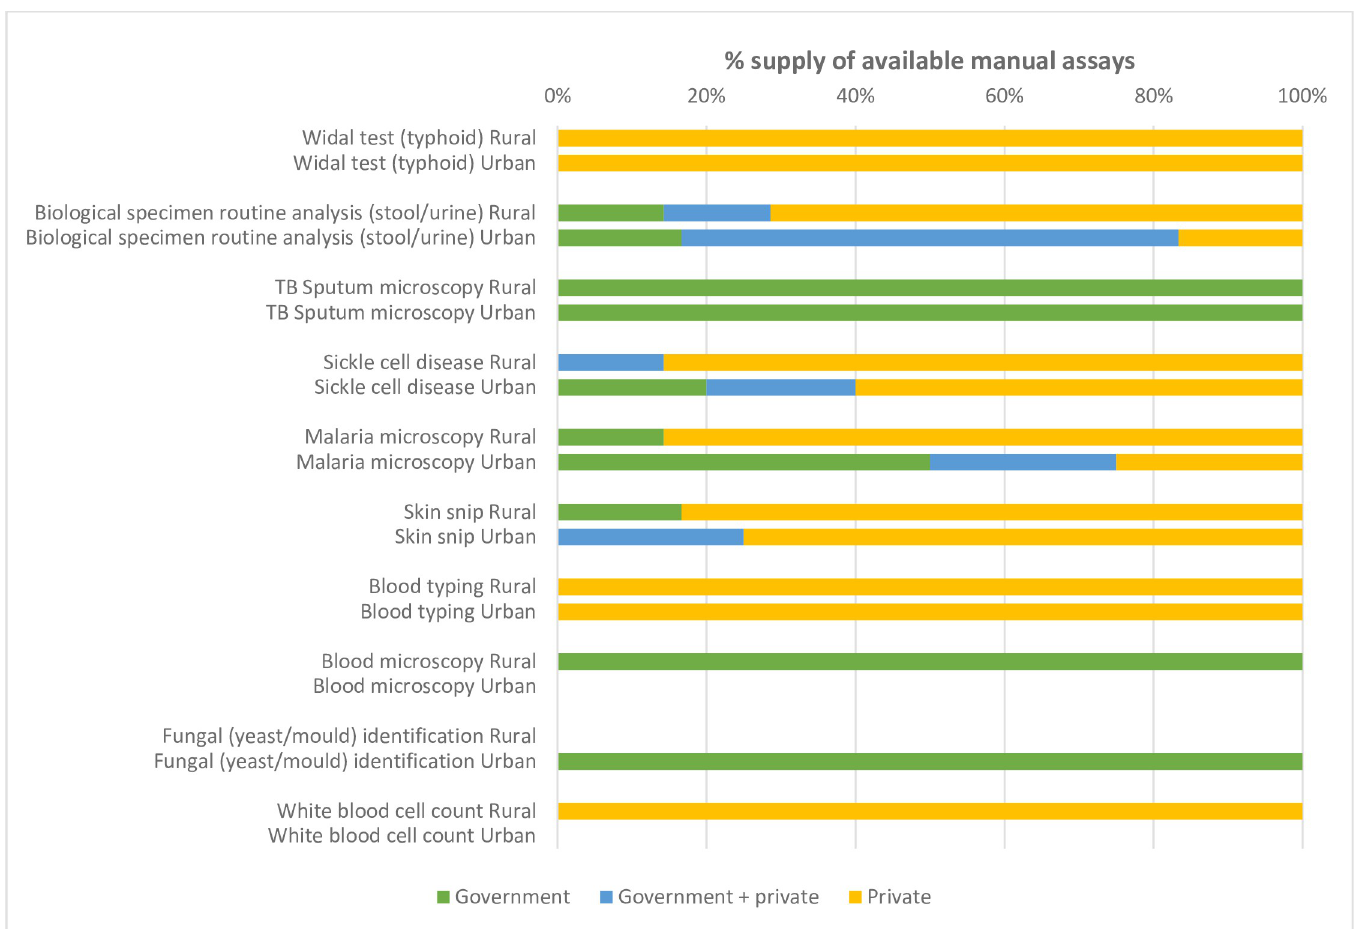
Fig 4. Supply sources of available assay-based tests. Note: Empty bars represent where there was no availability of tests.